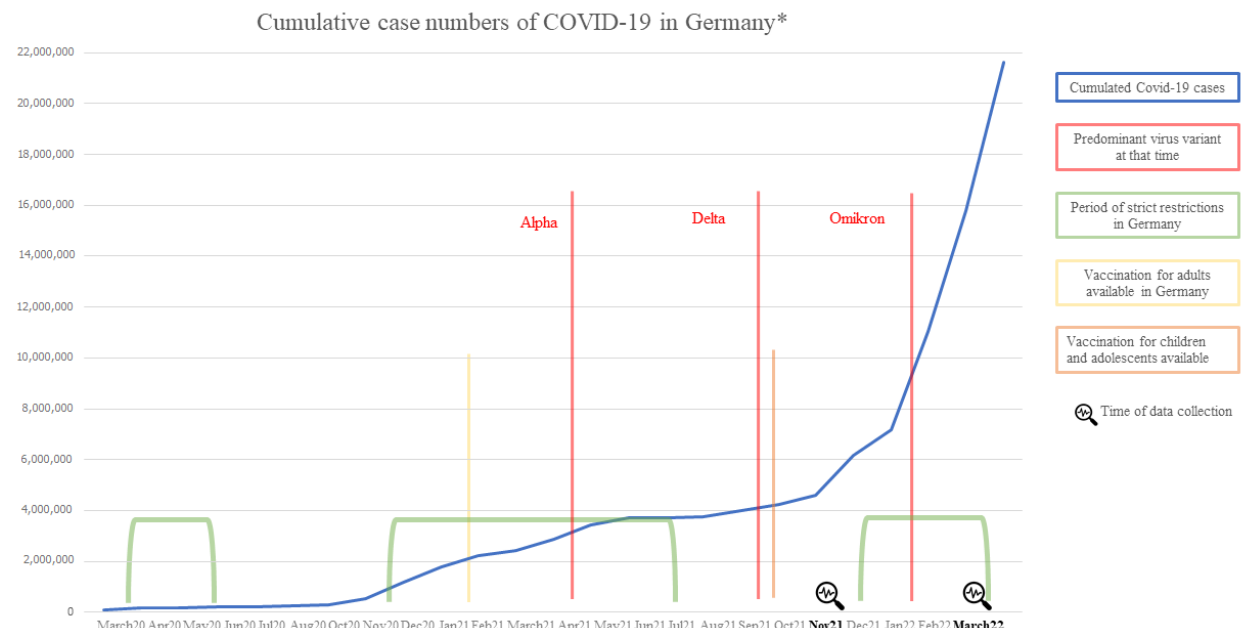
Figure 1. Chronology of COVID-19 in Germany (data based on WHO Health Emergency Dashboard 2022, * Data based on research of the RKI